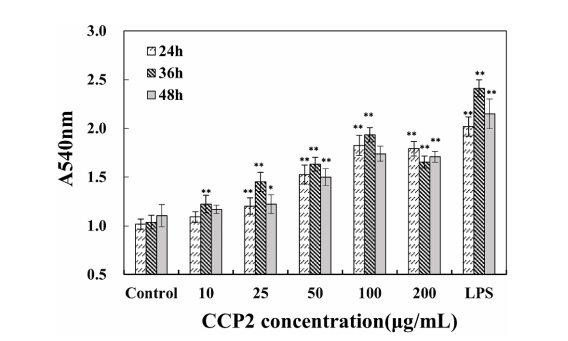
FIGURE3 Effects of CCP2 on the phagocytic activity of macrophages. Cells were treated with CCP2 at various concentrations (10, 25, 50, 100, 200, and 400 µ g/mL) for 24, 36, and 48 h, respectively. The control group was incubated with DMEM. ∗ p < 0.05 and ∗∗ p < 0.01 were significant when compared to the Control group. Data were expressed as means ±